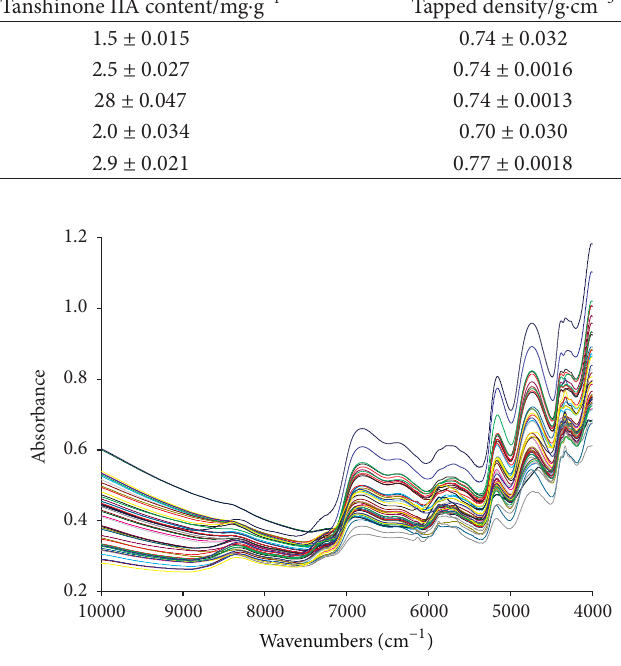
−1 7000 ∼ 4000 cm , serious peak overlapping and great noise could be observed, suggesting that a great deal of information may be